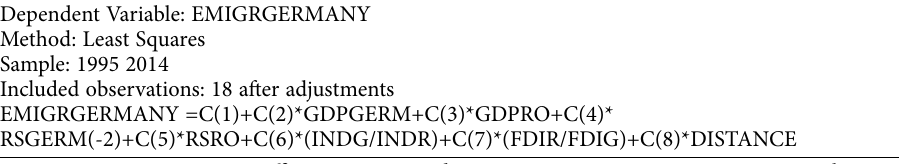
Dependent Variable: EMIGRGERMANY Method: Least